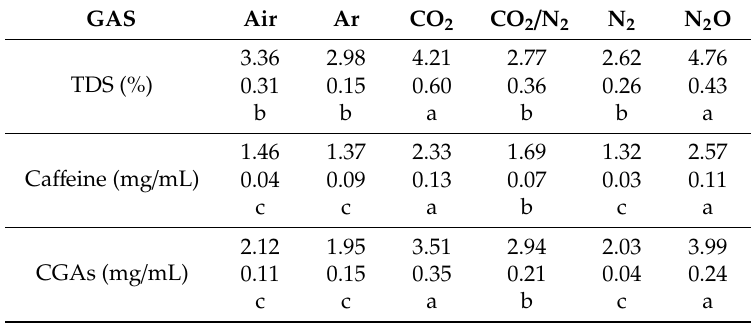
Table 2. Mean and standard deviation of physical-chemical parameters measured in solution. Di ff erent letters (a, b, and c) indicate statistically significant di ff erences ( p < 0.05 Tukey’s Test). GAS Air Ar CO 2 CO 2 / N